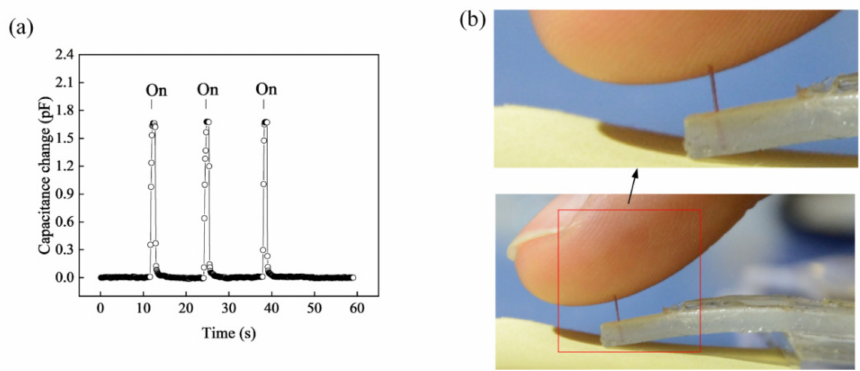
Figure 16. ( a ) Capacitance change with time for ( b ) fingertip pressing on and off the free end of the tactile